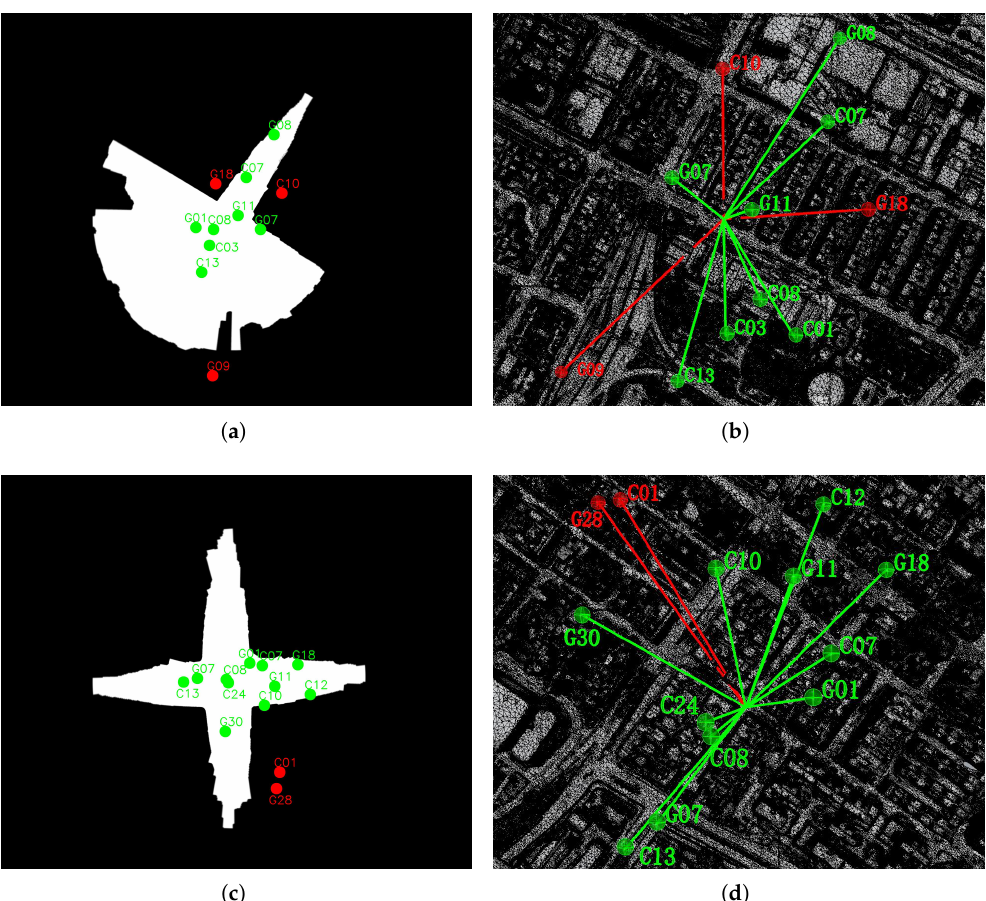
Figure 16. NLOS signal rejection results for the other two images. ( a ) NLOS signal rejection results of the first image. ( b ) Modeling results of the first image. ( c ) NLOS signal rejection results of the second image. ( d ) Modeling results of the second